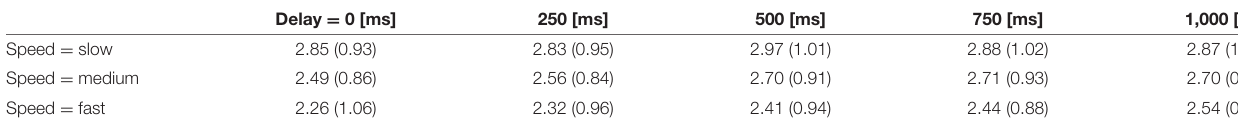
TABLE 5 | Average (standard deviation) of bumpiness rating scores.